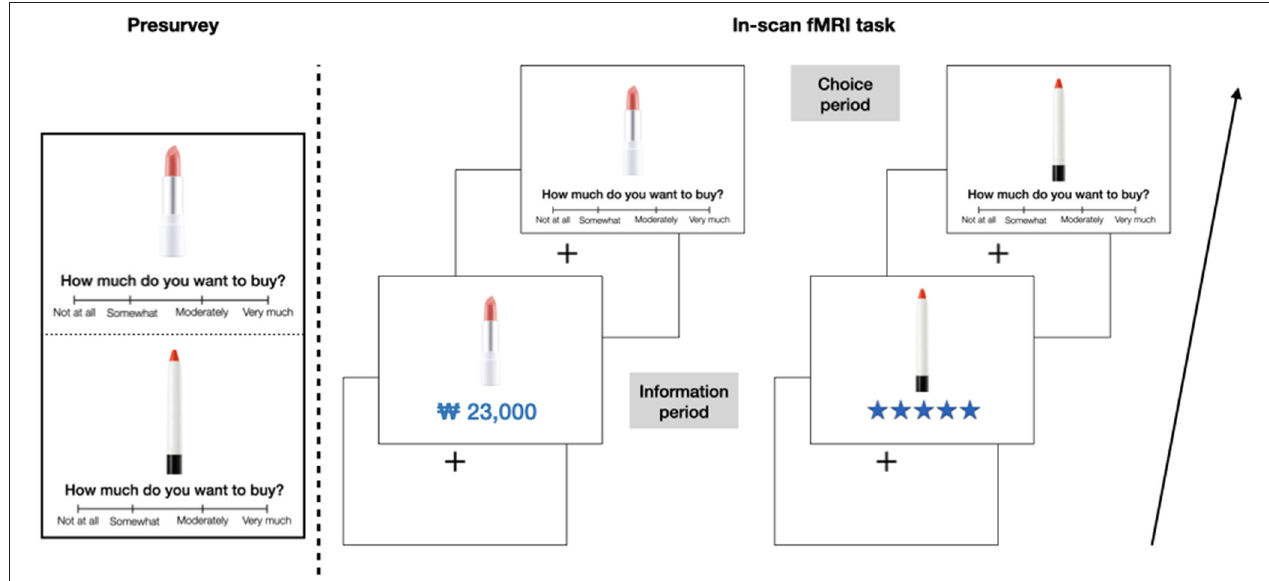
FIGURE 1 | Experimental design. Prior to the fMRI task, an online presurvey was conducted, where participants were asked to indicate their level of purchase intention on a 4-point Likert scale for each lip-care product. In the fMRI task, the same products were presented either with price or star rating information for 2s, and then, participants disclosed the level of purchase intention on the same scale once